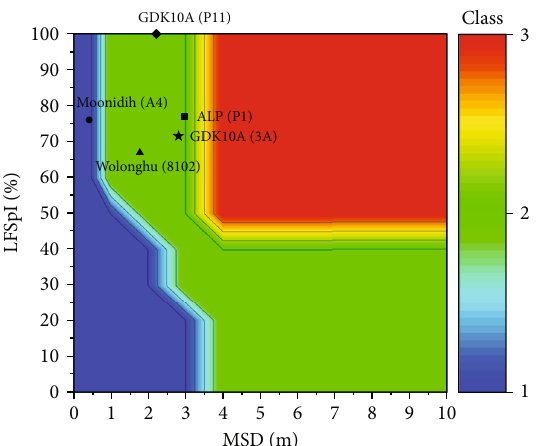
Figure 14: Classi fi cation of longwall panels based on CWSC